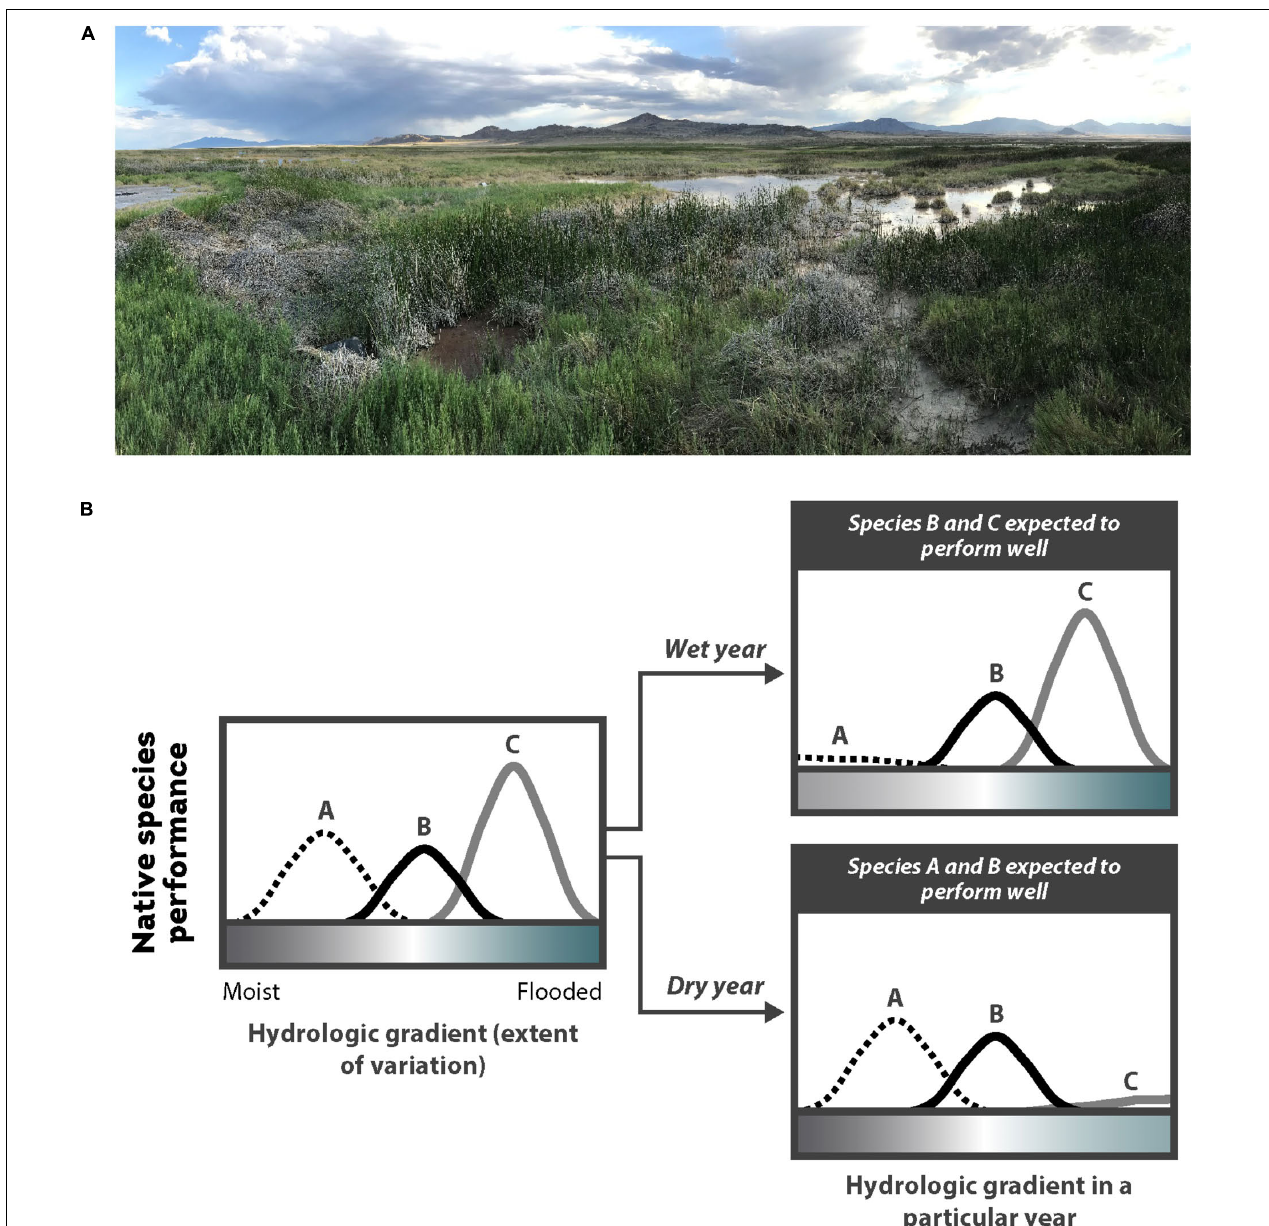
FIGURE 7 | (A) Wetlands are highly dynamic year-to-year and between years, such as in this desert wetland on the border of Utah and Nevada, United States (Salt Springs Waterfowl Management Area); and (B) the location and availability of safe sites for a particular species may vary, therefore, in a wetland due to the amount of water availability in a wet year vs. dry year. Thus, restoration practitioners often choose to sow a seed mix across a site and include a variety of species with different flooding and drought tolerances as a bet-hedging strategy within sites and between years. Adapted from Larson and Funk (2016), with permission from John Wiley and